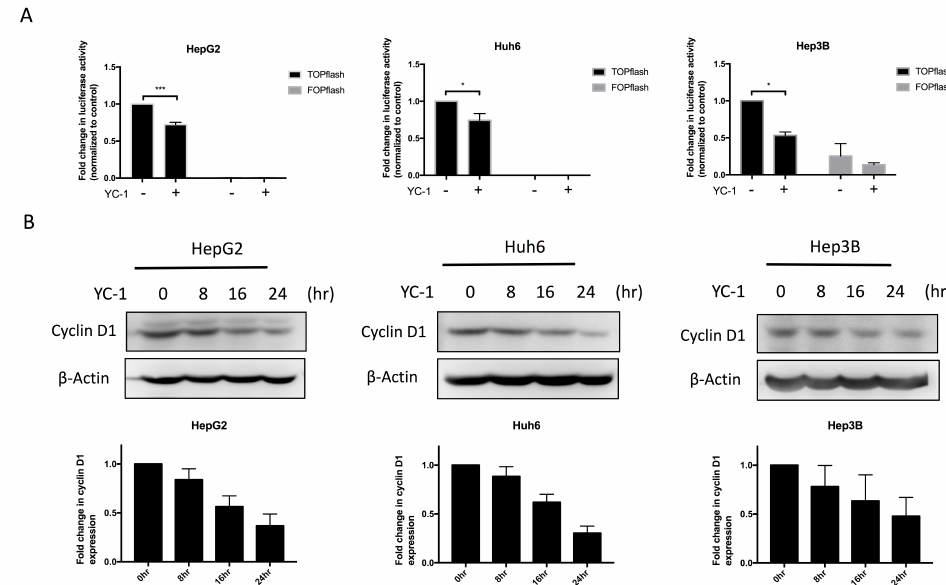
Figure 2. YC-1 inhibited Wnt signaling and cyclin D1 expression. The TOPflash reporter containing wild-type TCF / LEF binding sites produced a high level of transcriptional activity in HCC cells. The FOPflash reporter containing the mutated TCF / LEF binding sites was used as the negative control. The luciferase activity of TOPflash and FOPflash was analyzed after 6 h of treatment with the IC 50 of YC-1 ( A ). All HCC cell lines were exposed to the IC 50 of YC-1 for the indicated durations. The expression of cyclin D1 was analyzed by western blotting ( B ). * p < 0.05, *** p <